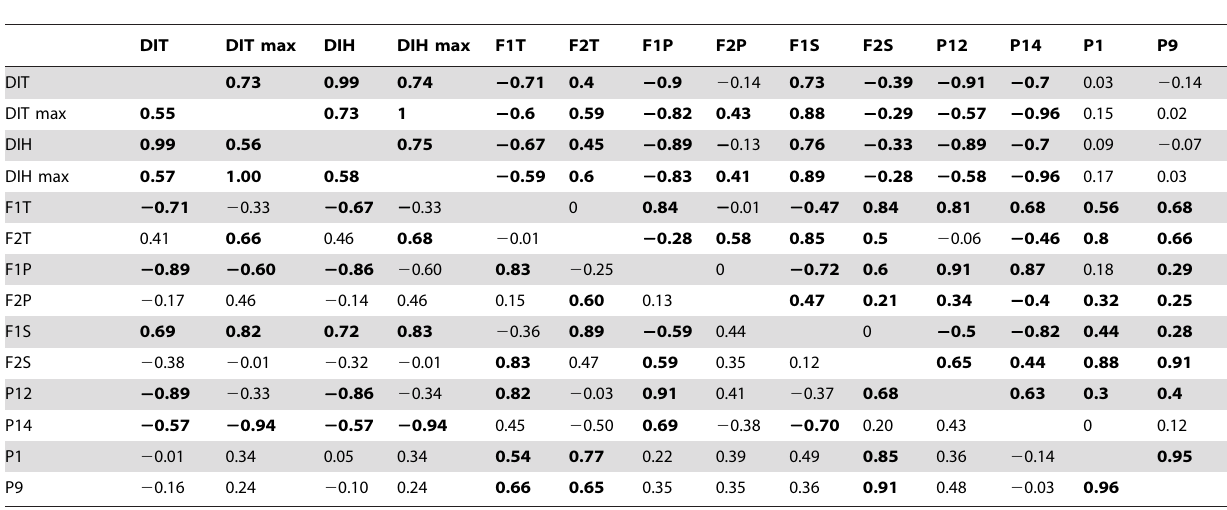
Table 3. Pearson’s correlation coefficients (r – above the diagonal) and Spearman’s rank correlation coefficients ( r – below the diagonal) among some representative climatic variables, components and drought severity